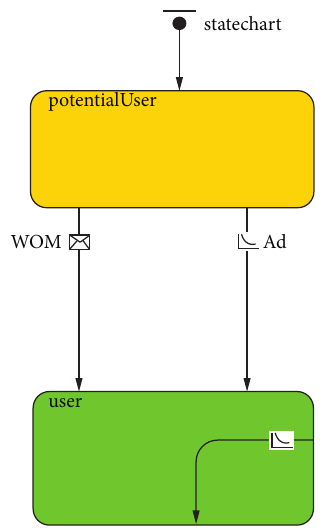
Figure 23: State chart for the customer agent type in the Bass diffusion AB